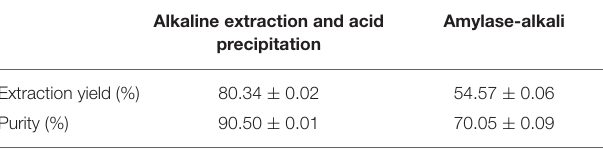
TABLE 2 | Extraction ratio and purity of protein from broken rice. Alkaline extraction and acid